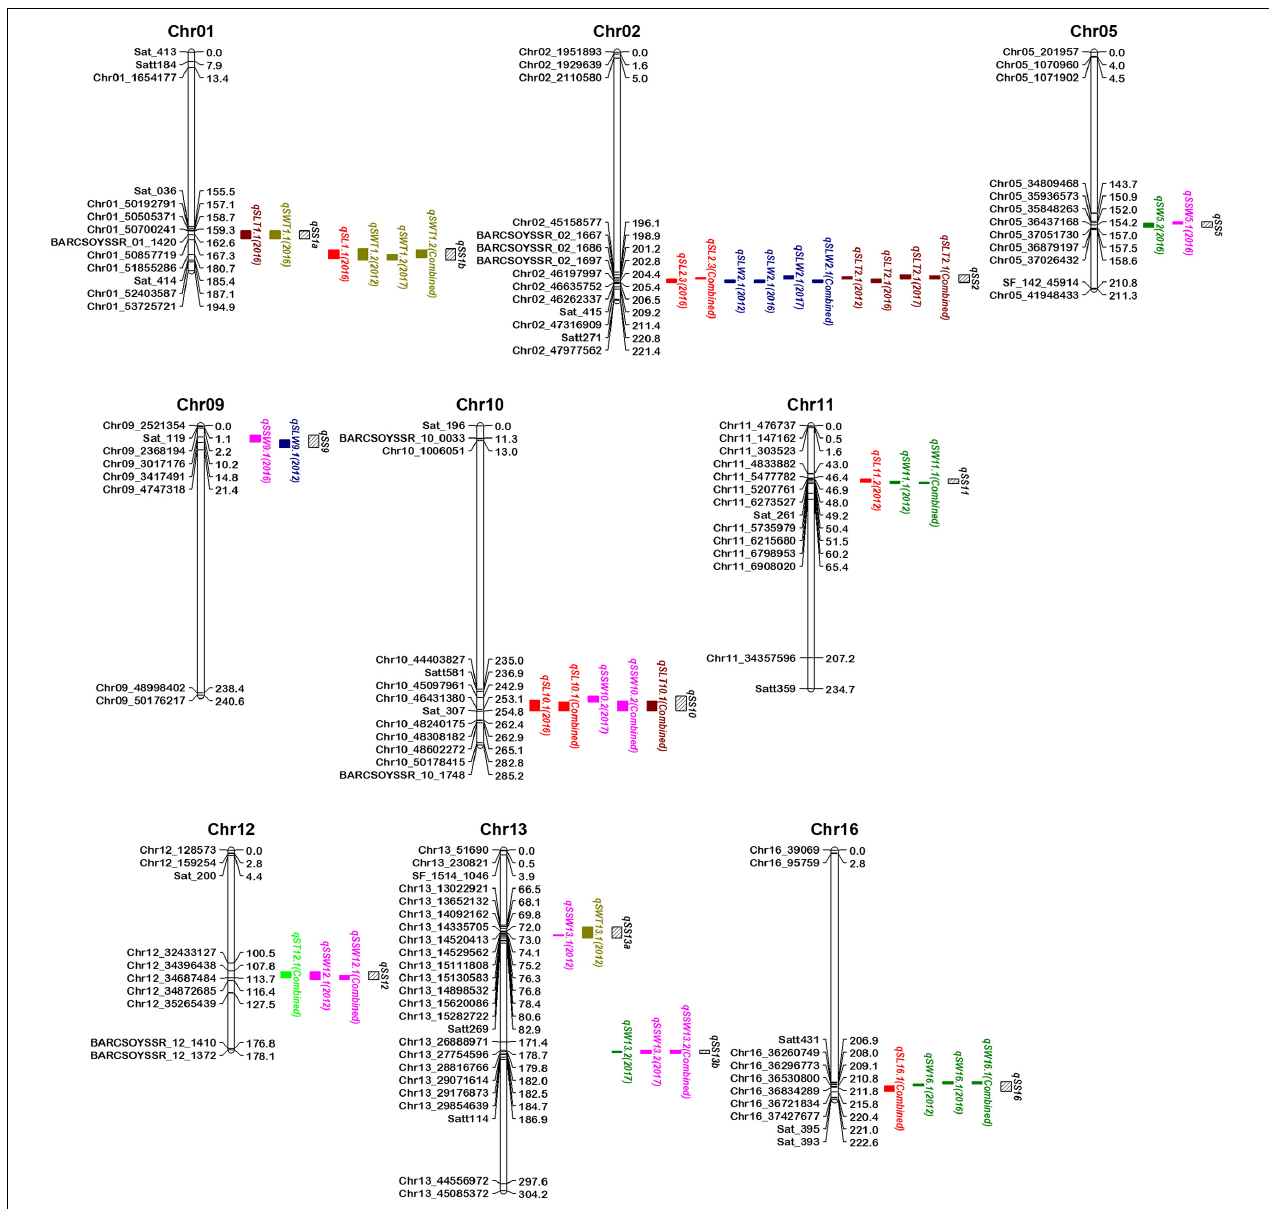
FIGURE 3 | Map positions of quantitative trait loci (QTLs) for seed size and shape traits present in 11 QTL clusters on the genetic linkage map of the K099 × Fendou 16 RIL population. Distances in cM are indicated to the right of the linkage groups and names of markers are shown on the left. Markers of only in and around identified QTLs are shown on chromosomes. Positions of different QTLs are represented by colored bars on the right of chromosomes. QTL names are followed by the environment (year) in parentheses depicting year of QTL expression. QTL cluster positions are depicted by black bars with slanting lines on the right of